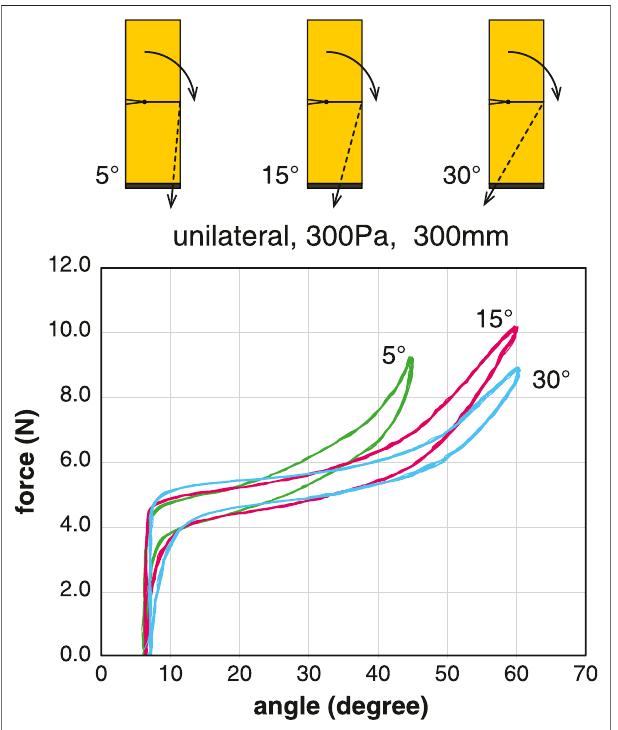
FIGURE 7 | Comparison of the tension-angle relationship at different tendon angles. The in fl atable used for the measurement was the U300. Plots of 10 cycles at the pressure condition of 300Pa.